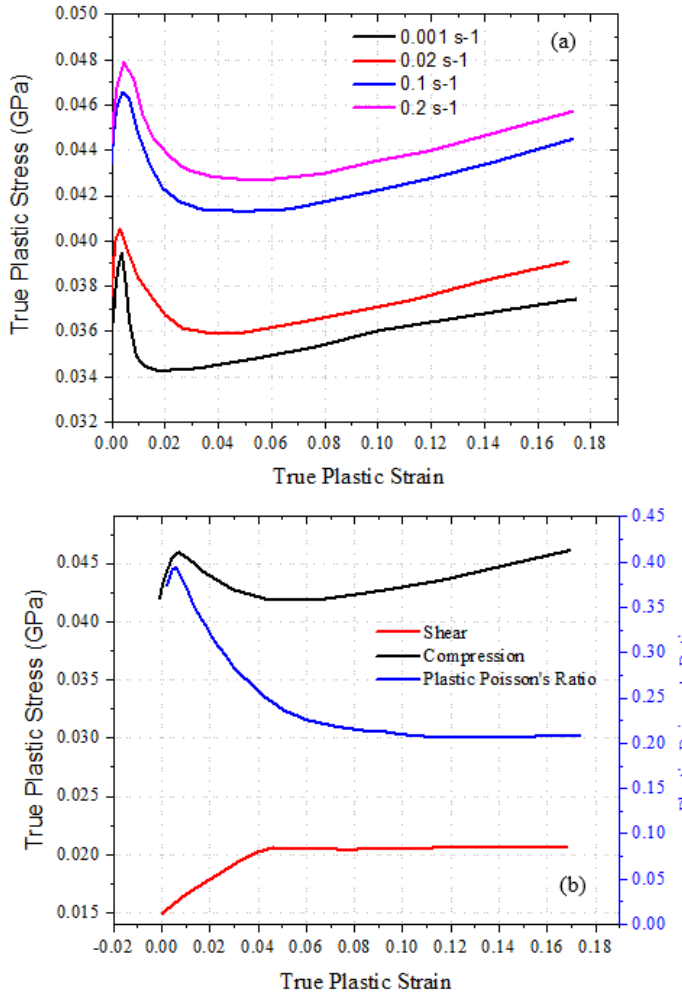
Figure 3. Input data for Acrylonitrile–Butadiene–Styrene (ABS) in Semi-Analytical material model (SAMP-1); ( a ) Tensile test, ( b ) compression, shear, and plastic Poisson’s ratio data.